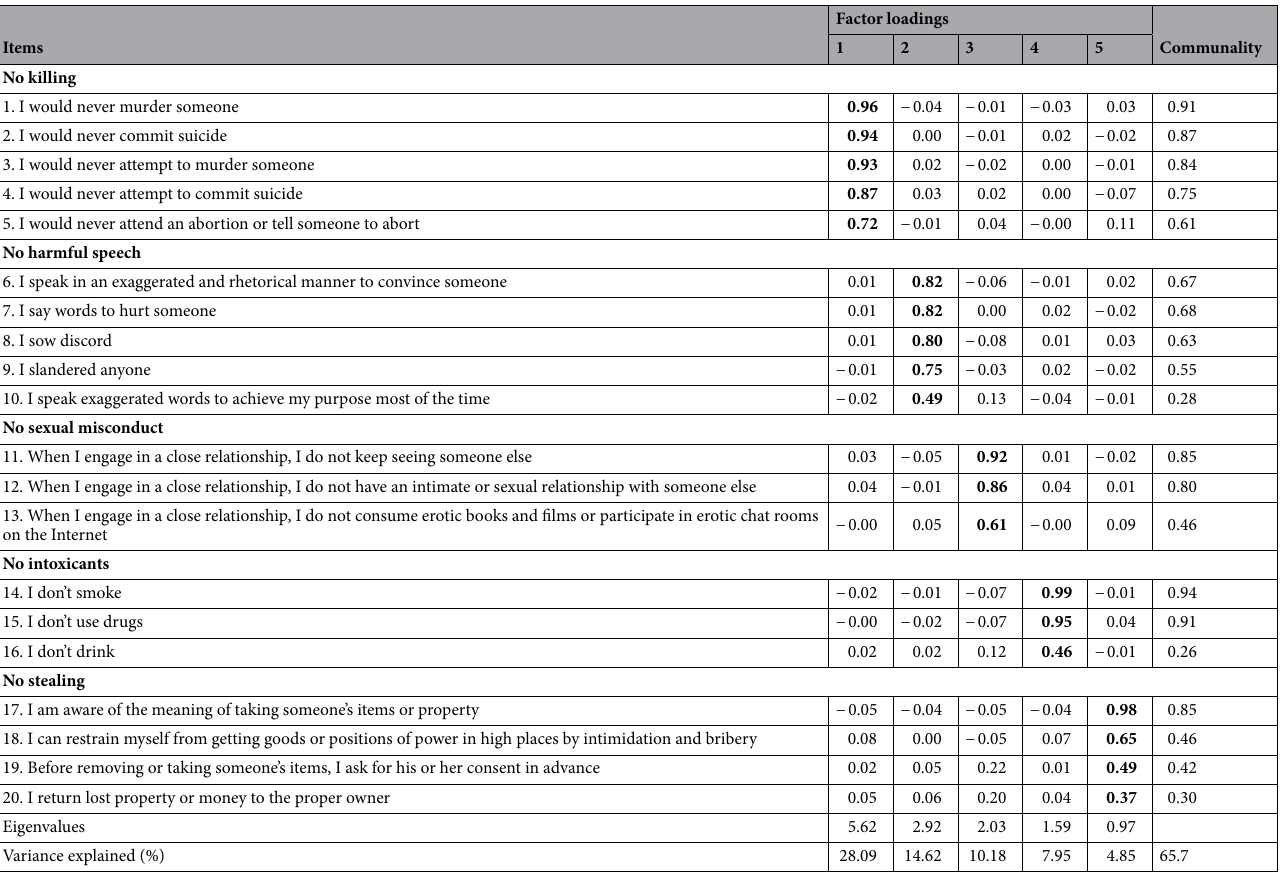
Table 2. Factor loadings and communalities for the five subscales of the Desire Questionnaire.